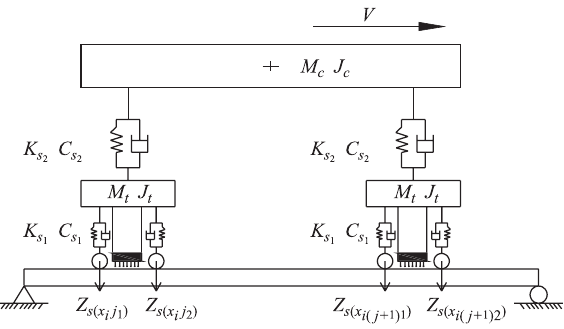
Fig. 1. LIM vehicle-bridge vertical coupling vibration